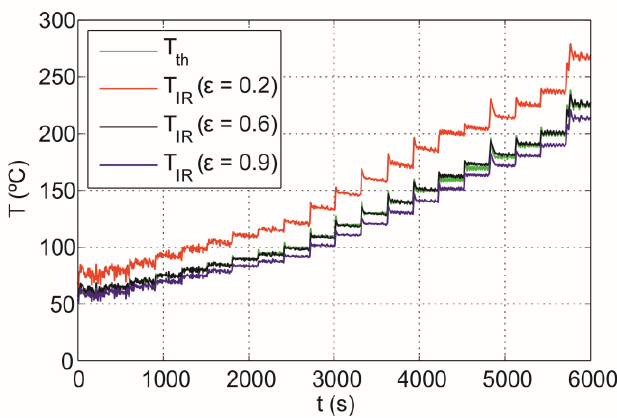
Figure 15. Estimated IR sensor temperature for different sample emissitivy